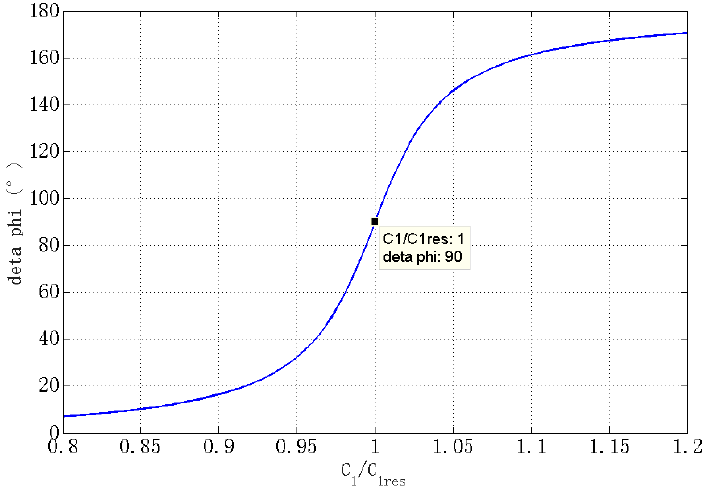
Figure 8. Function Δ φ ( C 1 ). Figure 8. Function ∆ φ ( C 1